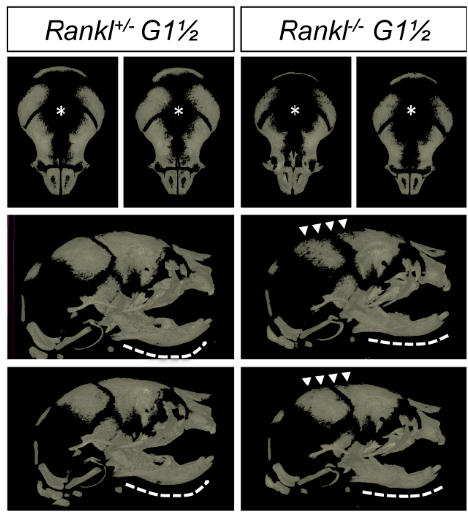
Figure 3. MicroCT comparative analysis of the craniofacial skeleton of pups born from null mutant females and heterozygous males. Heterozygous and null mutant pups revealed craniofacial phenotypes that were respectively similar to first- and second-generation null mutants. Enlarged foramina (stars) were present, more pronounced in the null mutants (arrowheads), and the mandibles of the null mutants appeared flat (dotted lines) as in the second-generation null mutants. Percentage of closure measures (surface) for the two genotypes are 65 ± 4 for +/ − and 54 ± 7 for − / − . Angle of the mandible curvature measures (opening degrees) for the two genotypes are 133 ± 10 for +/ − , 159 ± 12 for 1 − / − . Numbers of pups: 4 +/ − and 2 − / −